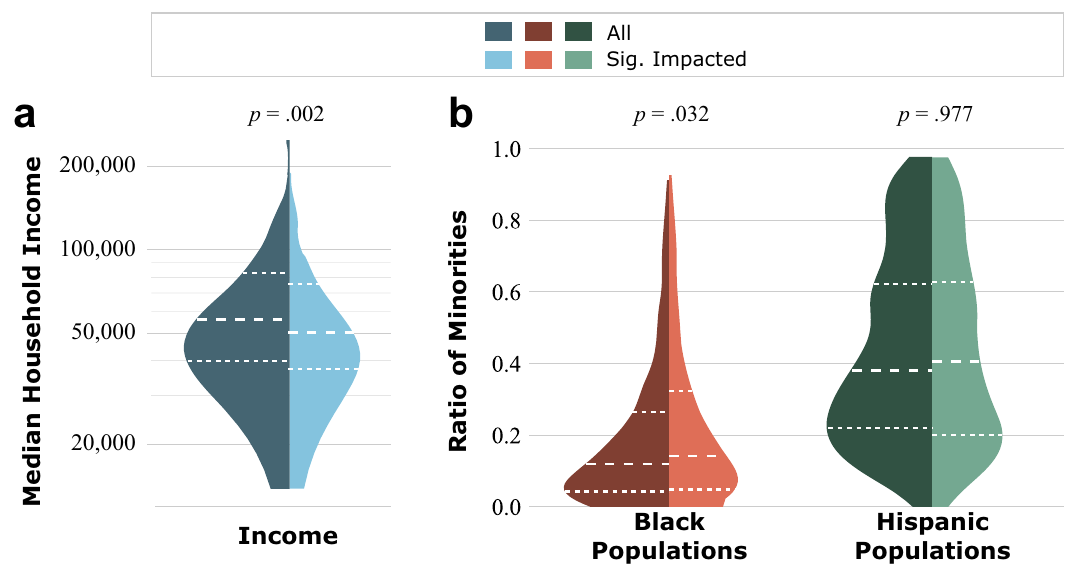
Fig. 8 Comparison between all census tracts and the impacted census tracts due to pipe bursts in Harris County from the aspects of income, race, and ethnicity. The aspects of income, race, and ethnicity are represented by a median household income, b Black and Hispanic population ratio. The impacted census tracts have a lower median income and higher median ratios of Black and Hispanic populations, indicating that the low income and high ratio of Black populations census tracts experienced greater impacts of pipe bursts during the winter storm.